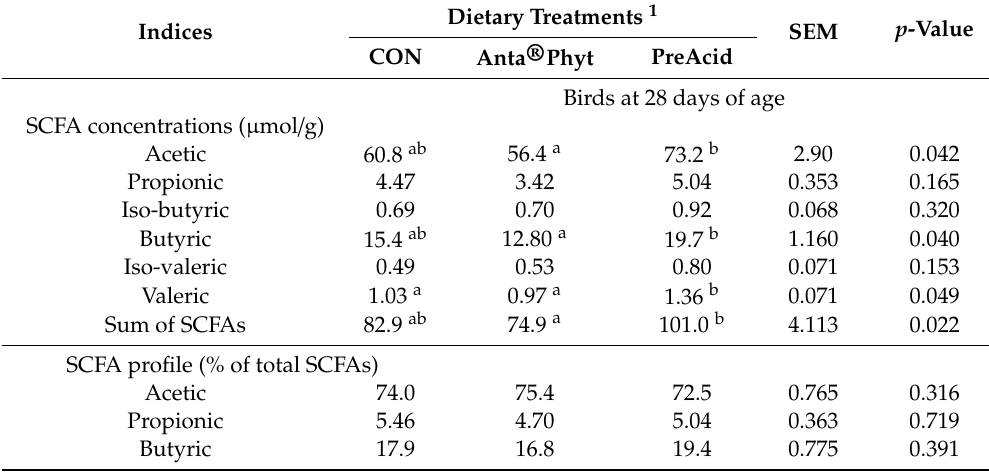
Table 1. Effect of dietary treatments on short-chain fatty acid (SCFA) concentrations in the cecal digesta of chickens at 28, 35, and 42 days of age.